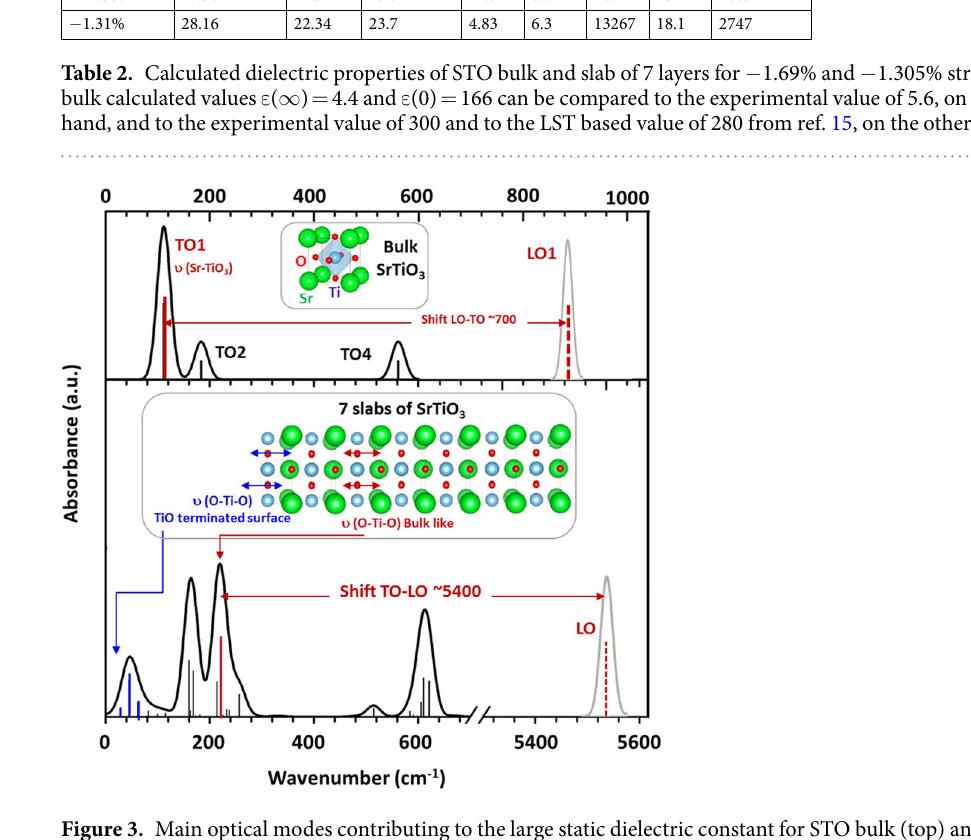
of Table 2, which shows that the dielectric constant of the slab is mainly due to the in-plane component. From the LST relation, a very high value of ε (0) may arise from two effects; (i) when a particular ω TOj tends to zero with a non-zero LO-TO shift, (ii) when a particular LO-TO shift tends to infinity. In the present case, both effects contribute and the very high value of ε (0) (13267) is mainly obtained from the contribution of four peaks: the three peaks of the surface/soft modes (SM) and the peak at 220 cm − 1 (See Fig. 3). In Fig. 3, the main contributions to the static dielectric constant are illustrated for the bulk (top of the figure) and for the − 1.305% strained slab of 7 layers (bottom of the figure). In the bulk, the lowest frequency phonon TO 1 -LO 1 at 112 cm − 1 –846 cm − 1 is the main contribution to the static dielectric con- stant. The other two (TO 2 -LO 2 and TO 4 -LO 4 ) contribute only marginally. In the strained slab, the transverse modes between 100 and 200 cm − 1 and at ~600 cm − 1 are caused respectively by the transformation of TO 1 and TO 2 (mixed contribution of Sr-TiO 3 stretching and O-Ti-O bending for atoms located in the middle of the slab), and TO 4 (mainly Ti-O stretching for atoms located in the middle of the slab). At lower frequencies (under 100 cm − 1 ), the modes can be assigned to surface components of mixed Ti-O bending and stretching contributions parallel to the TiO 2 -terminated surface while the lowest frequency mode is a pure bending of O-Ti-O at this surface. The